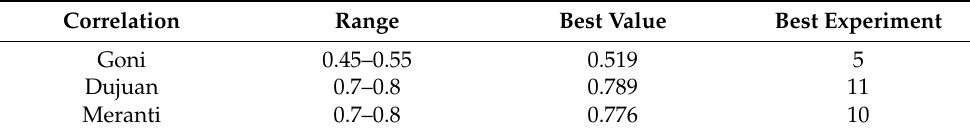
Table 13. R statistics of the significant wave height simulation in the three typhoon events. Correlation